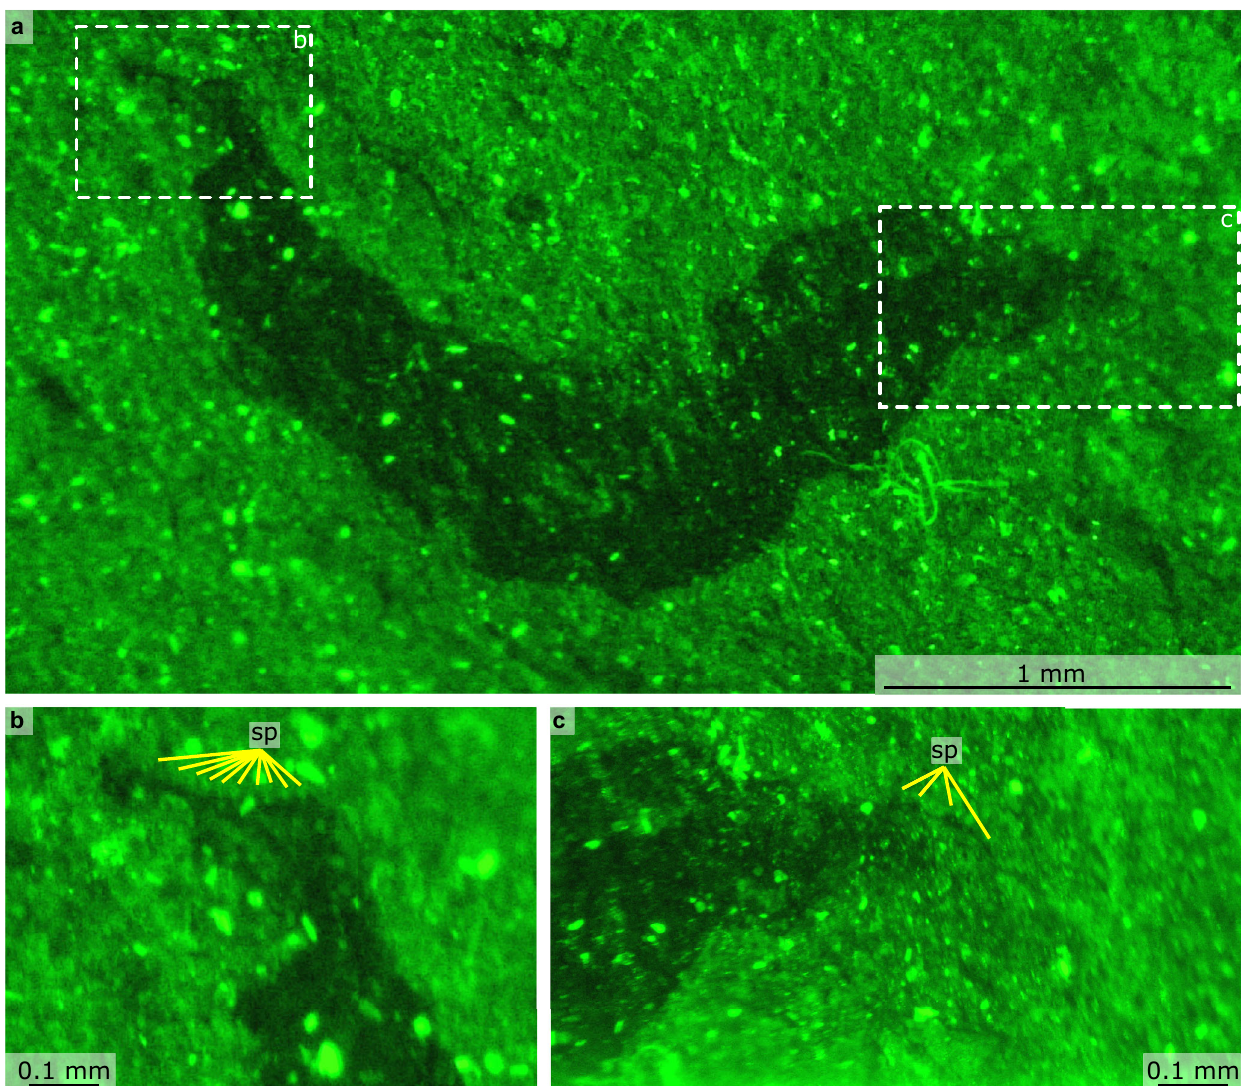
Fig. 8 | Details of Castle Bank euarthropod A (NMW.2021.3G.8), photographed using fl uorescence. a Overview of whole specimen. b Details of tail fan with spinose margin. c Details of proboscis with dorsal spines. sp